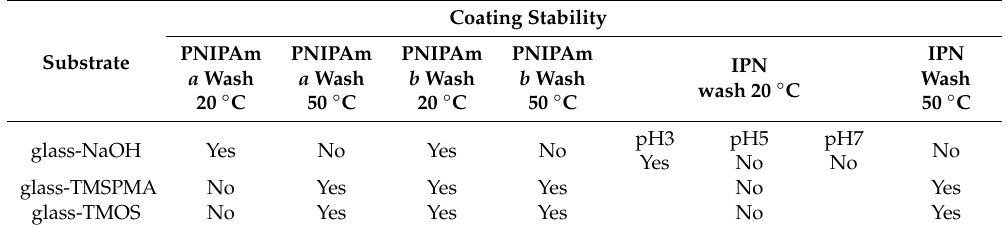
Table 2. Film stability evaluated, after water washing, with a scratch test. Yes = the film was still detectable after washing; No = the film could not be detected after